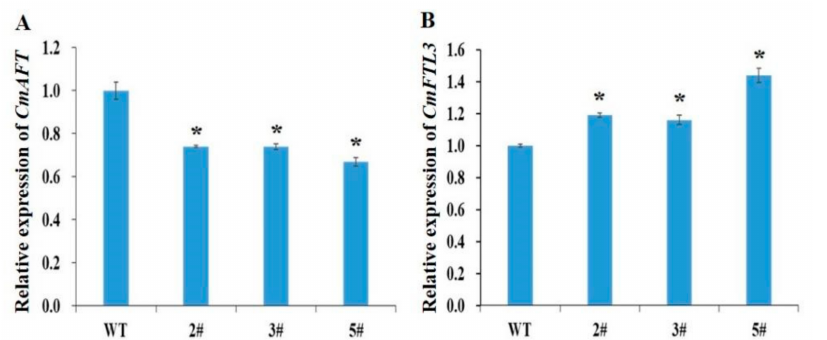
Figure 6. Relative expression levels of flowering-related genes in the WT plants and Ox transgenic lines. ( A , B ) The relative expression of CmAFT and CmFTL3 in the leaves of WT and Ox plants. Values represent means ± SE ( n = 3), and the significant differences were determined using Student’s t test (* p < 0.05).